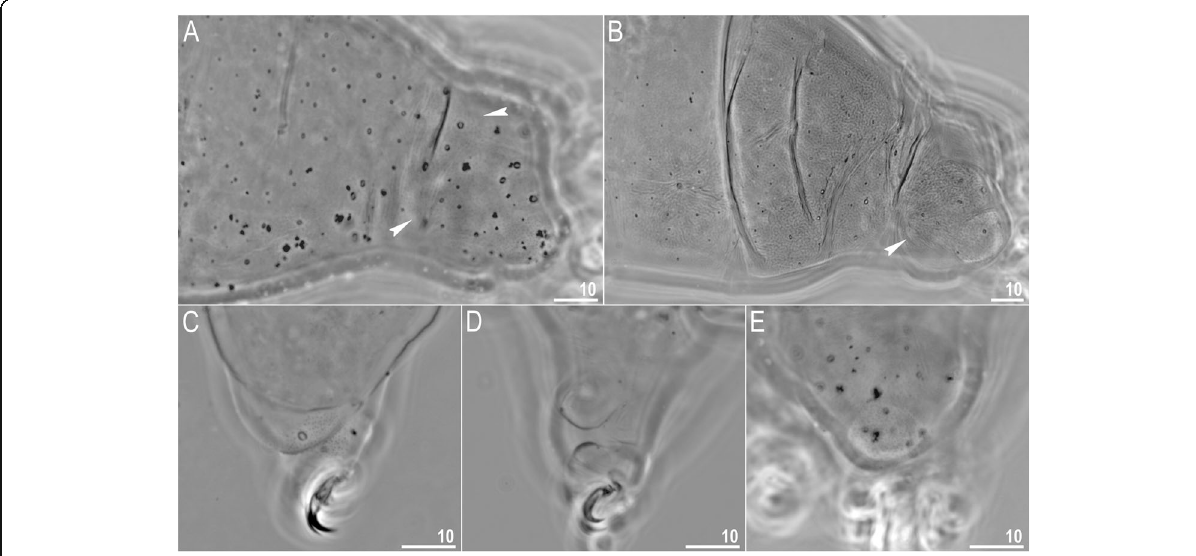
Fig. 22 Macrobiotus ripperi sp. nov. from Poland (PL.015) – body and leg cuticle morphology seen with LCM: a – b – band of caudal granulation on the last body segment clearly visible in specimen with stretched cuticle ( a ) and hardly visible in specimen with wrinkled cuticle ( b ); c – granulation on the external surface of leg III; d – internal surface of leg II with evident pulvinus; e – granulation on dorsal surface of leg IV. Filled indented arrowheads indicate sparse granulation in the caudal band. Scale bar in μ